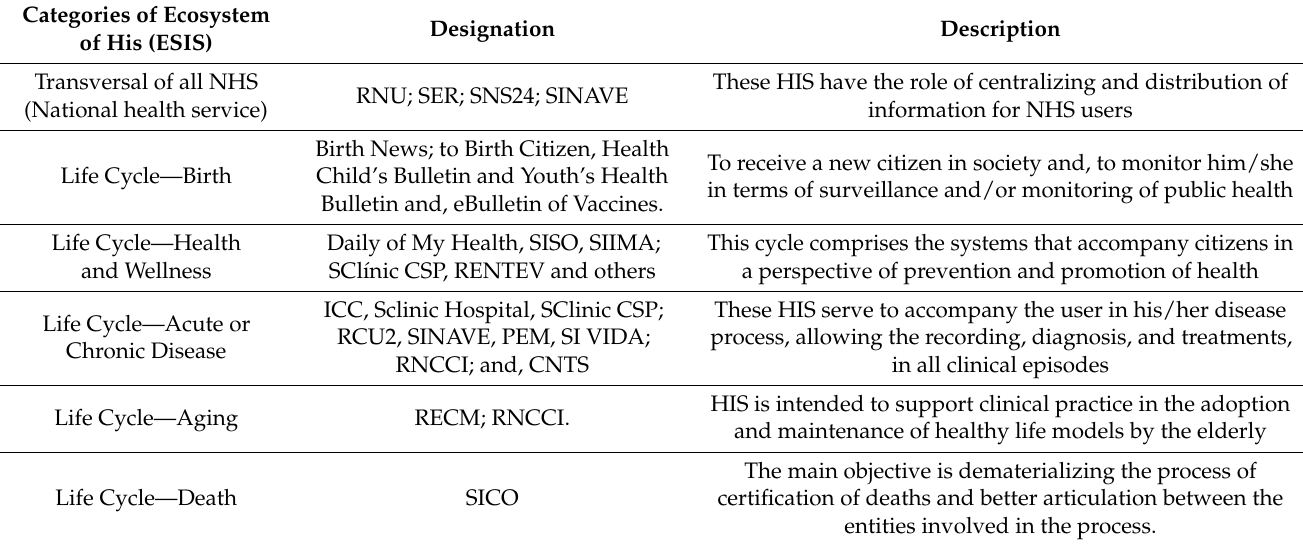
Table 2. Health Information Ecosystem in